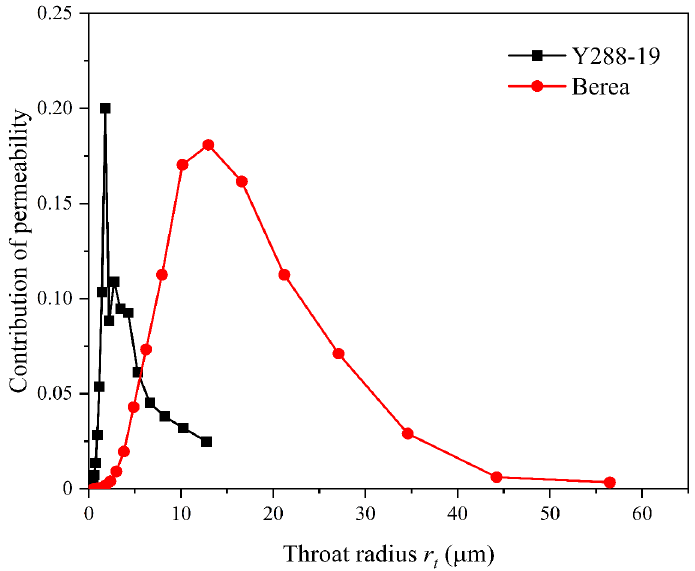
Figure 10. Throat radius distribution and absolute permeability contribution curve of two types of cores.